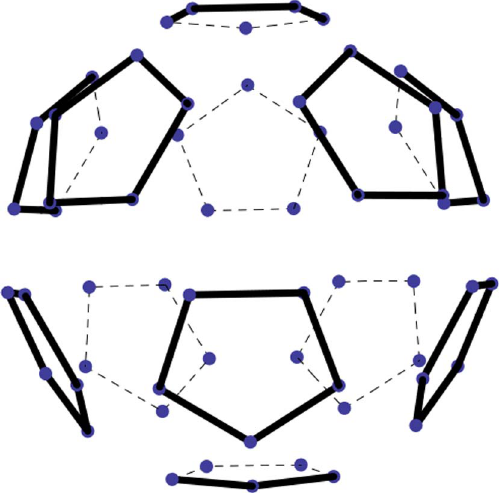
Figure 3. The 12 pentagons of the surface of C 60 are shown without the hexagons. The 60 dots are the vertices of C 60 . The polytope is oriented as in Fig. 1.